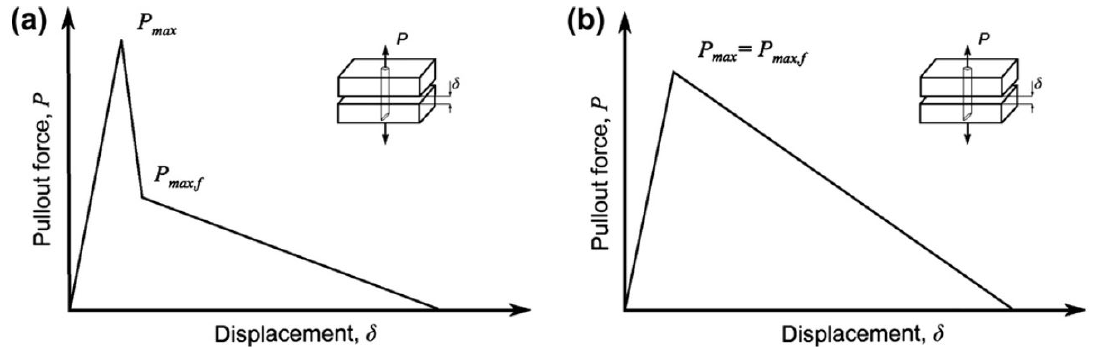
F igure 12. ( a ) Tri-linear z-Pin response and ( b ) bi-linear z-Pin response [21]. Figure 12. ( a ) Tri-linear z-Pin response and ( b ) bi-linear z-Pin response